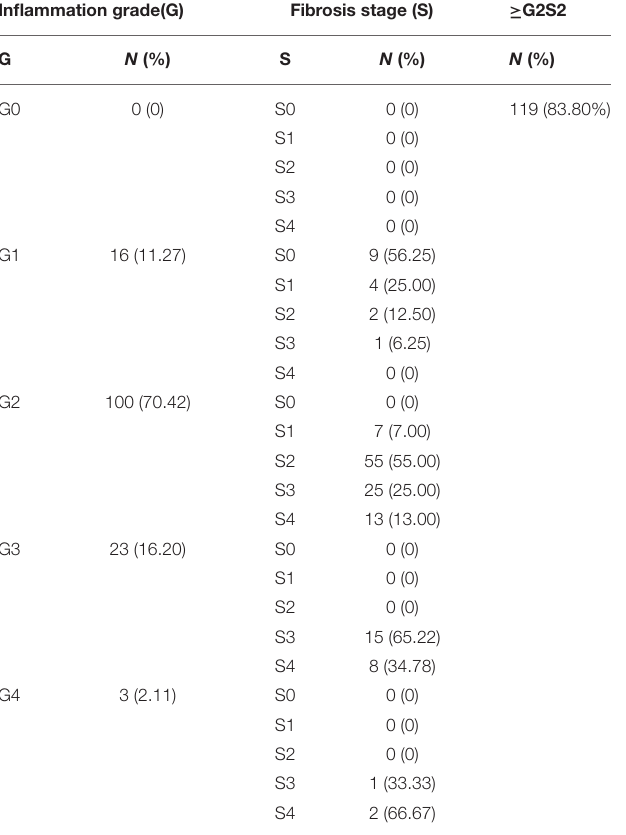
TABLE 1 | Inflammation grade and fibrosis stage of 142 patients with HBsAg-positivity and HBeAg-negativity. Inflammation grade(G) Fibrosis stage (S)